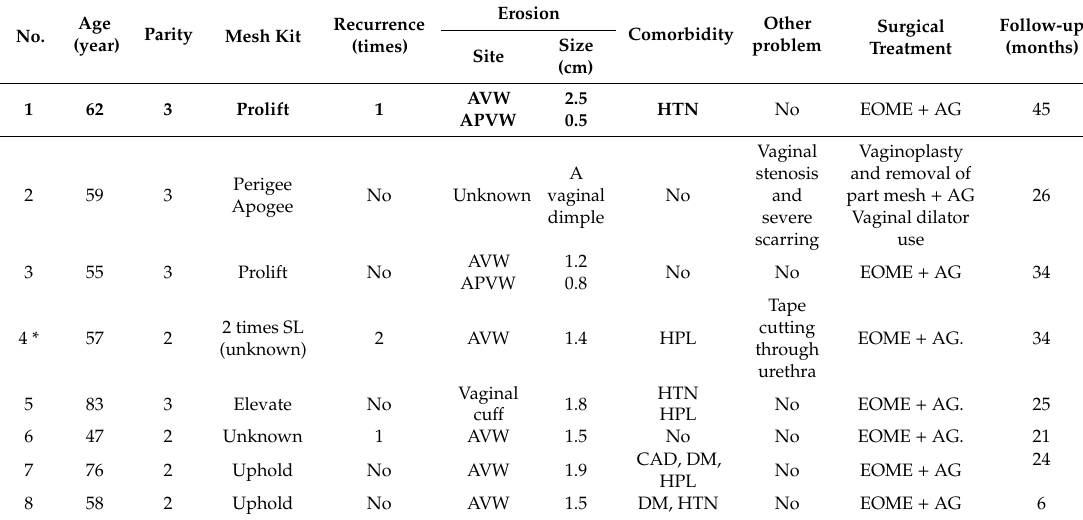
Table 1. The characteristics of the patients.